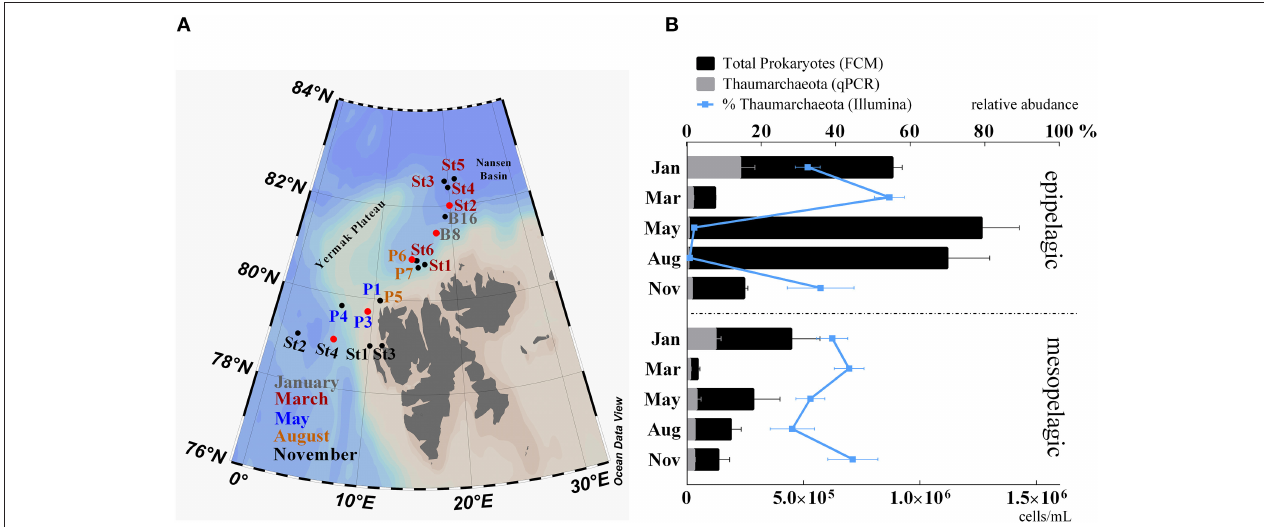
FIGURE 1 | (A) Study area Northwest of Svalbard. Stations are colored according to their time of sampling: gray, January; red, March; blue, May; yellow, August; black, November. Stations marked with a red circle were selected for amoA functional gene analyses. (B) Abundance of prokaryotes counted by flow cytometry (black bars) and superimposed abundance of Thaumarchaeota (gray bars) determined by qPCR of 16S rRNA genes. Relative abundance of Thaumarchaeota in relation to the total of 16S rRNA genes from Illumina sequencing data is shown by the blue line. Samples were grouped in epipelagic (0–200m; n = 28) and mesopelagic (200–1,000m; n = 22) zones and according to their sampling month. Standard errors were calculated for average values and are indicated as error